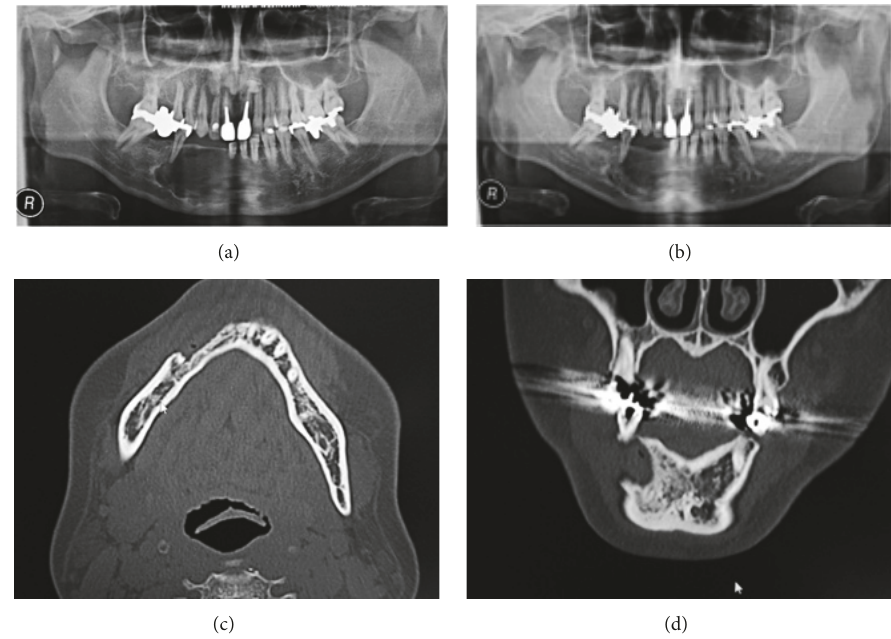
Figure 6: (a) A panoramic radiograph obtained just after the operation showing a well-defined large unilocular radiolucent lesion in the right mandible. (b) A panoramic radiograph and (c) axial and (d) coronal computed tomography obtained at 22 postoperative months showing that the radiopaque area had increased in